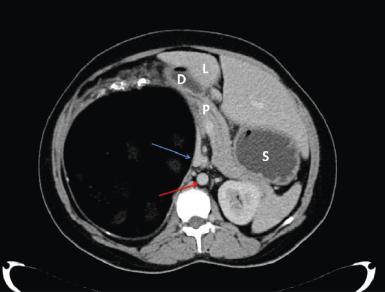
Figure 4: Histologic sections at low power reveal ectodermal components of the skin, sebaceous glands ( ↓ ), and smooth muscle ( ■ ) within the cyst wall. Mature adipocytes are present elsewhere in the photomicrograph. ∗ Cross section through the smooth